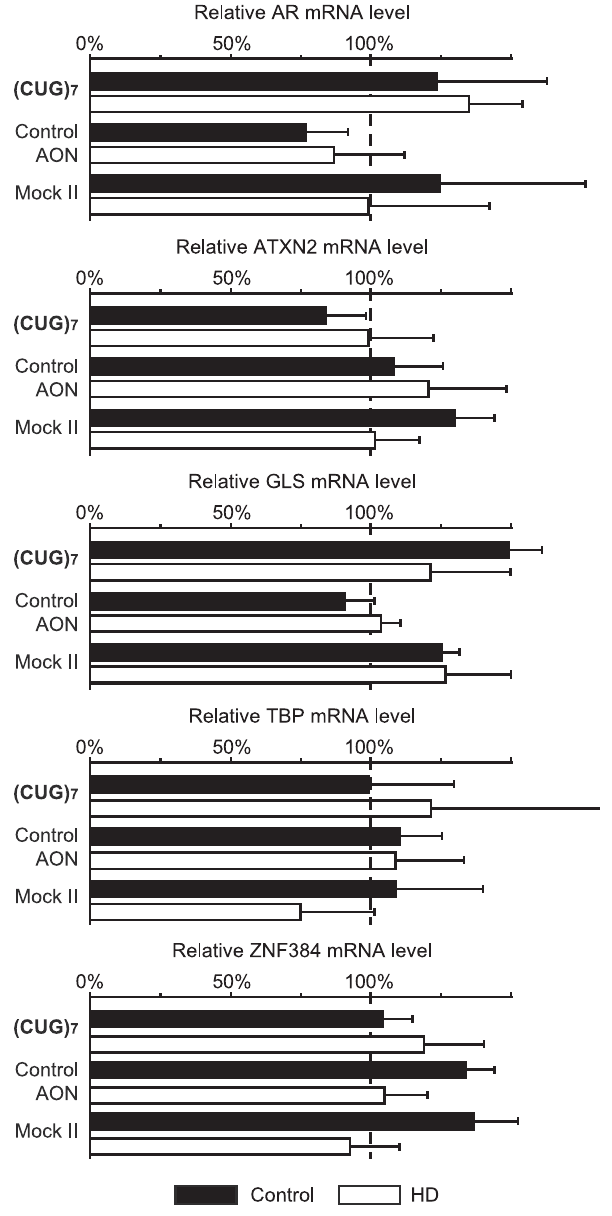
Figure 7. (CUG) 7 AON does not affect other CAG-containing transcripts. Quantitative real-time PCR was used to measure androgen receptor (AR), ataxin-2 (ATXN2), glutaminase (GLS), TATA box binding protein (TBP), and zinc finger protein 384 (ZNF384) mRNA levels in control and HD fibroblasts after treatment with 100 nM (CUG) 7 , non-htt specific h40AON2 (Control AON), transfection agent only (Mock II), or non-transfected cells (Mock I). All tested CAG-enclosing transcripts were unaffected by (CUG) 7 treatment. ACTB and RPL22 are used as reference genes. The expression level of Mock I transfections were set on 100% (n=6).